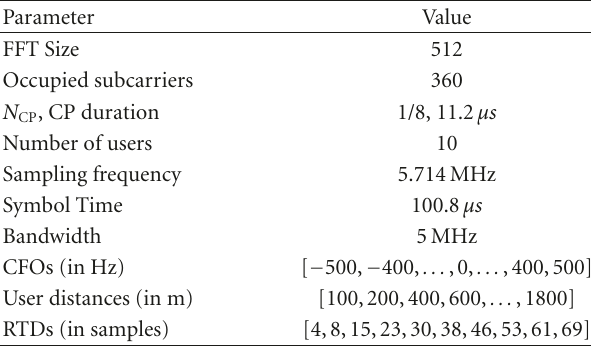
Table 1: Simulation parameters.